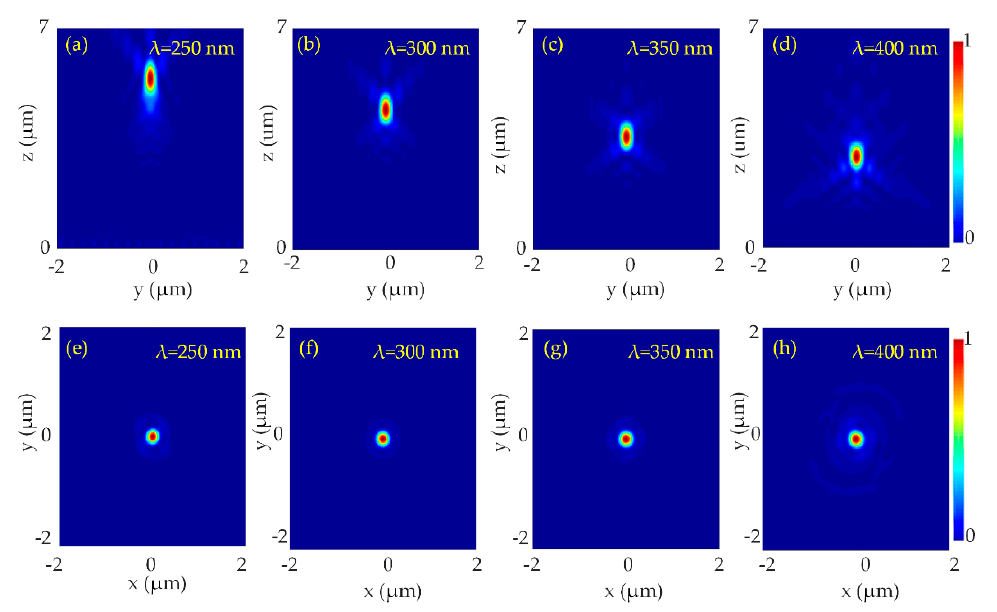
Figure 3. Focusing characteristics of UV metalense at incident UV light 250–400 nm. Normalized intensity distribution at y-z plane at ( a ) λ = 250 nm, ( b ) λ = 300 nm, ( c ) λ = 350 nm and ( d ) λ = 400 nm. Normalized intensity distribution of the metalens at x-y plane at x = y = 0. ( e ) λ = 250 nm along x-axis at z = 5.3 µ m, ( f ) λ = 300 nm, along x-axis at z = 4.4 µ m ( g ) λ = 350 nm, along x-axis at z = 3.5 µ m and ( h ) λ = 400 nm, along x-axis at z = 2.9 µ m. The metalens has a diameter of 10 µ m, the numerical aperture (NA) of the metalens at designed wavelength λ d = 300 nm is 0.75.